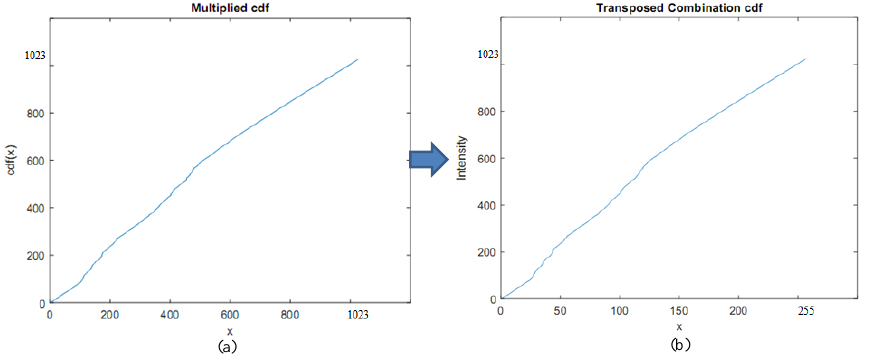
Figure 6. The extended and scaled histogram in the high dynamic range (10 bits). ( a ) An extended histogram from the LDR histogram of the intensity image. ( b ) The scaled histogram with the original image to obtain the same intensity values.